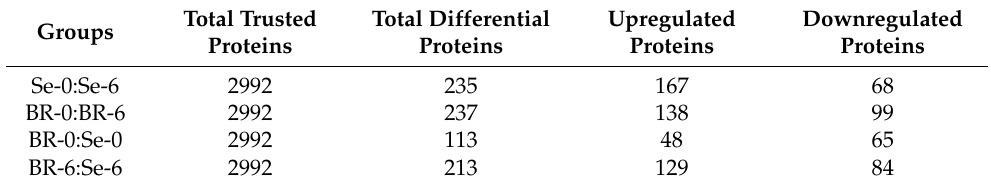
Table 2. Statistics of different proteins (DEPs) identified by different